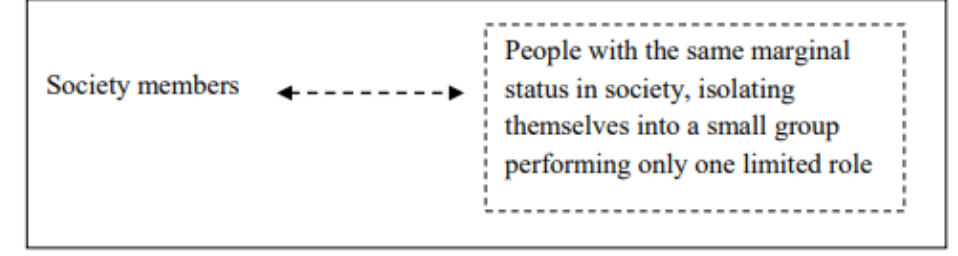
Diagram 4. Retreat Strategy Model